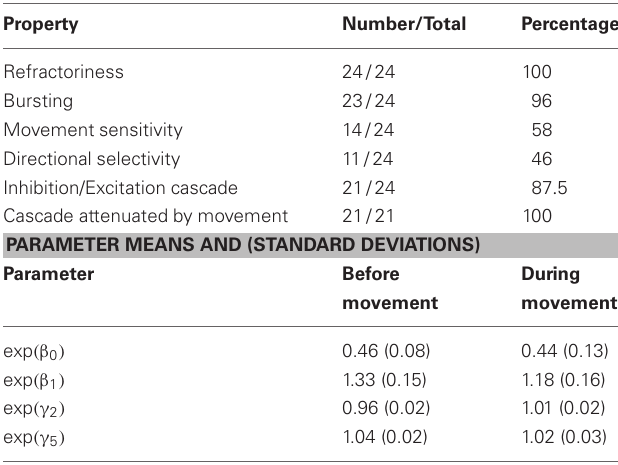
Table 1 | Population summary for oscillatory